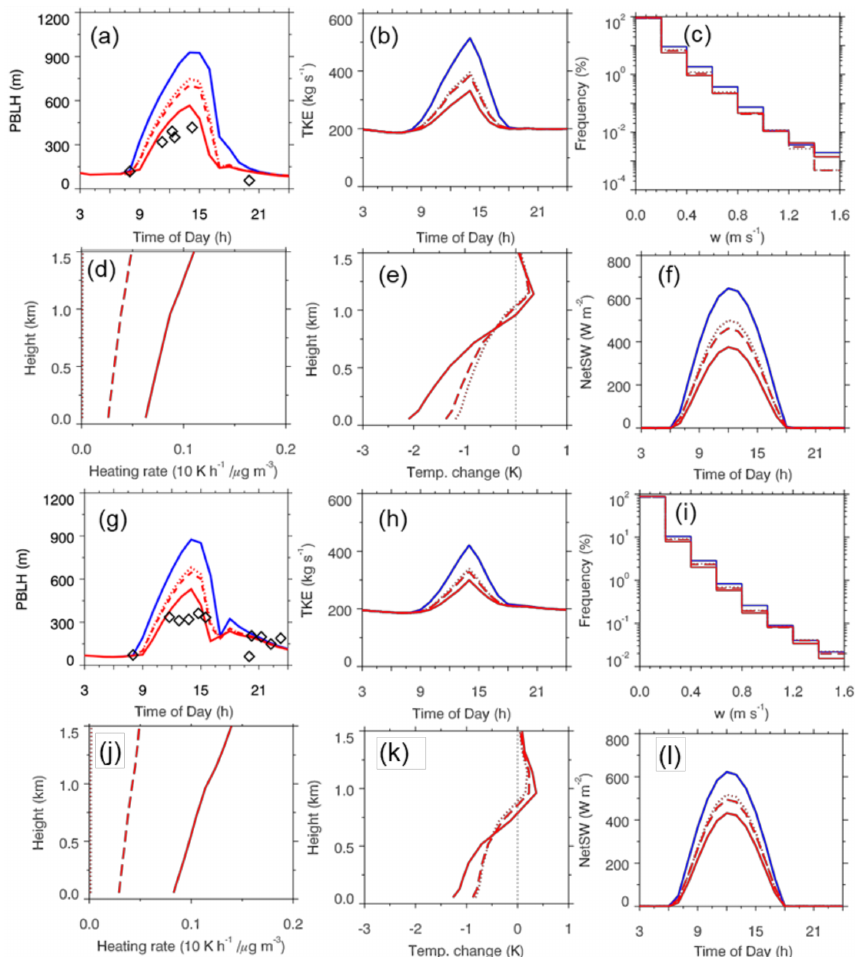
Figure 5. Simulated meteorological conditions and thermodynamic and dynamic feedbacks under the clean conditions (blue solid) and the polluted conditions for the non-BC (red dot), fresh-BC (red dashed), and aged-BC (red solid) cases. Panels (a) and (g) correspond to simulated diurnal variations of PBL height, (b) and (h) correspond to the diurnal variations of vertically integrated TKE, and (c) and (i) represent the frequency distribution of updraft. Panels (d) and (j) are the vertical profile of the shortwave heating rate per unit aerosol mass for the non-BC (red dot line), fresh-BC (red dash line), and aged-BC (red solid line) cases. Panels (e) and (k) are similar to (d) and (j) but for the temperature changes. Panels (f) and (l) are diurnal evolutions of net surface shortwave radiation (NetSW). Panels (a–f) are for EP1 and (g–n) are for EP2. The black hollow squares in (a) and (g) denote measurements of PBL height from